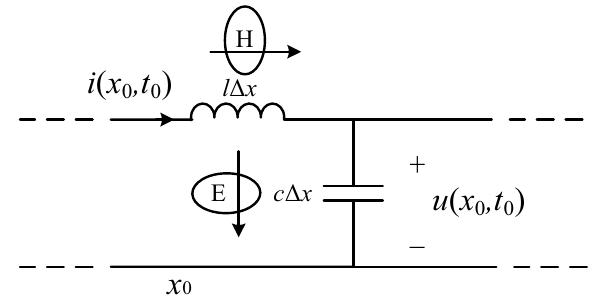
Figure 1. Schematic diagram of traveling wave energy